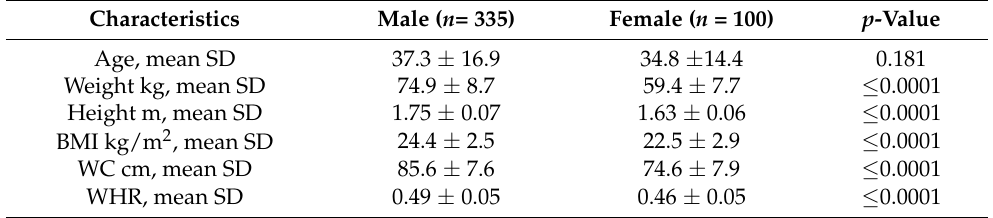
Table 1. Population